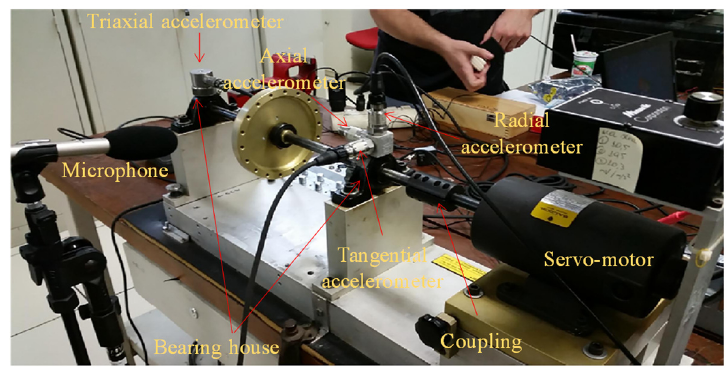
Figure 2. Experimental setup to obtain the MaFaulDa dataset [47].